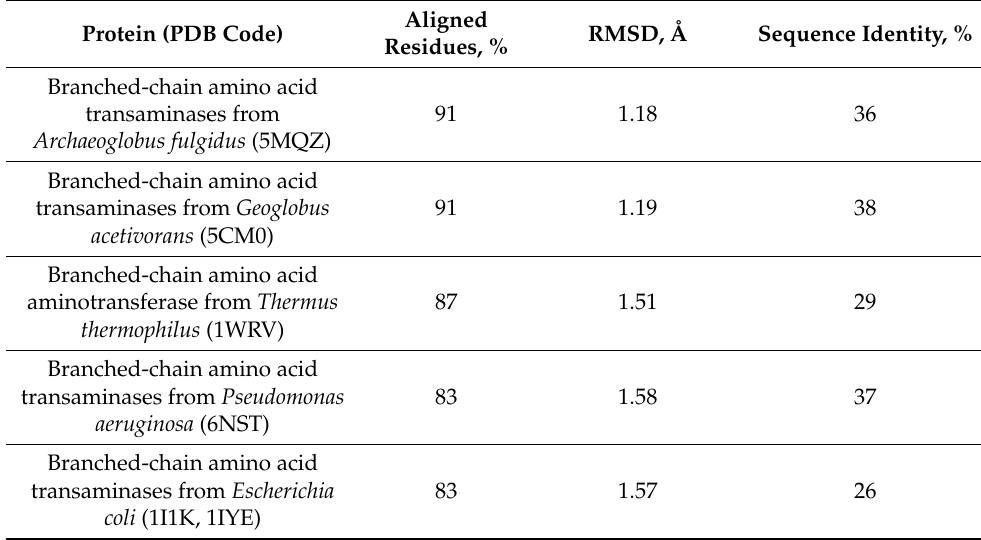
Table 2. Superposition of the VP5454 with the closest homologs. Superposition was made for one protein